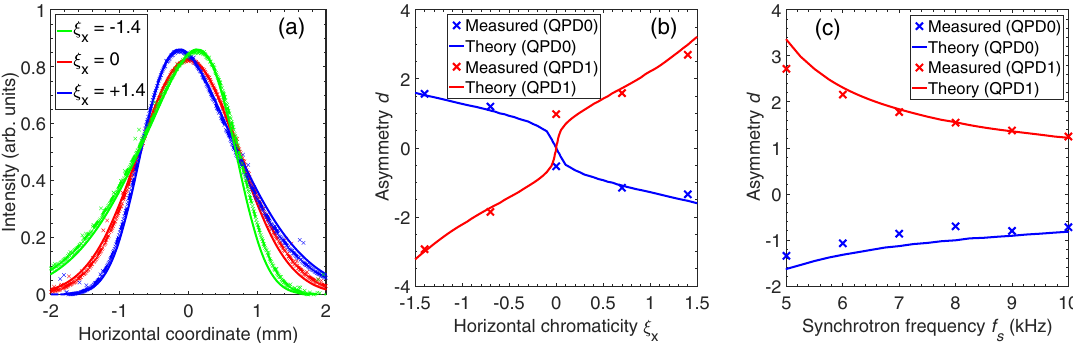
FIG. 3. Horizontal beam profile distortion from Gaussian by horizontal chromaticity. (a) Typical horizontal beam profile at QPD1 with α ¼ − 7 × 10 − 5 under three different ξ x . The closed-orbit movements of the ideal particle due to the sextupole strengths changes when adjusting ξ x have been compensated in the plot. Cross: beam imaging system measurement results. Dashed line: fit of the measurement data by an exponentially modified Gaussian function Eq. (8). Solid line: theoretical prediction. (b) Measured and theoretical asymmetry parameter d versus ξ x at QPD0 and QPD1 with f s ¼ 5 kHz ( α ¼ − 7 × 10 − 5 ); (c) Measured and theoretical asymmetry parameter d versus f s at QPD0 and QPD1 with ξ x ¼ 1 . 4 . All the theoretical curves are obtained based on Eq. (4) and Eq.